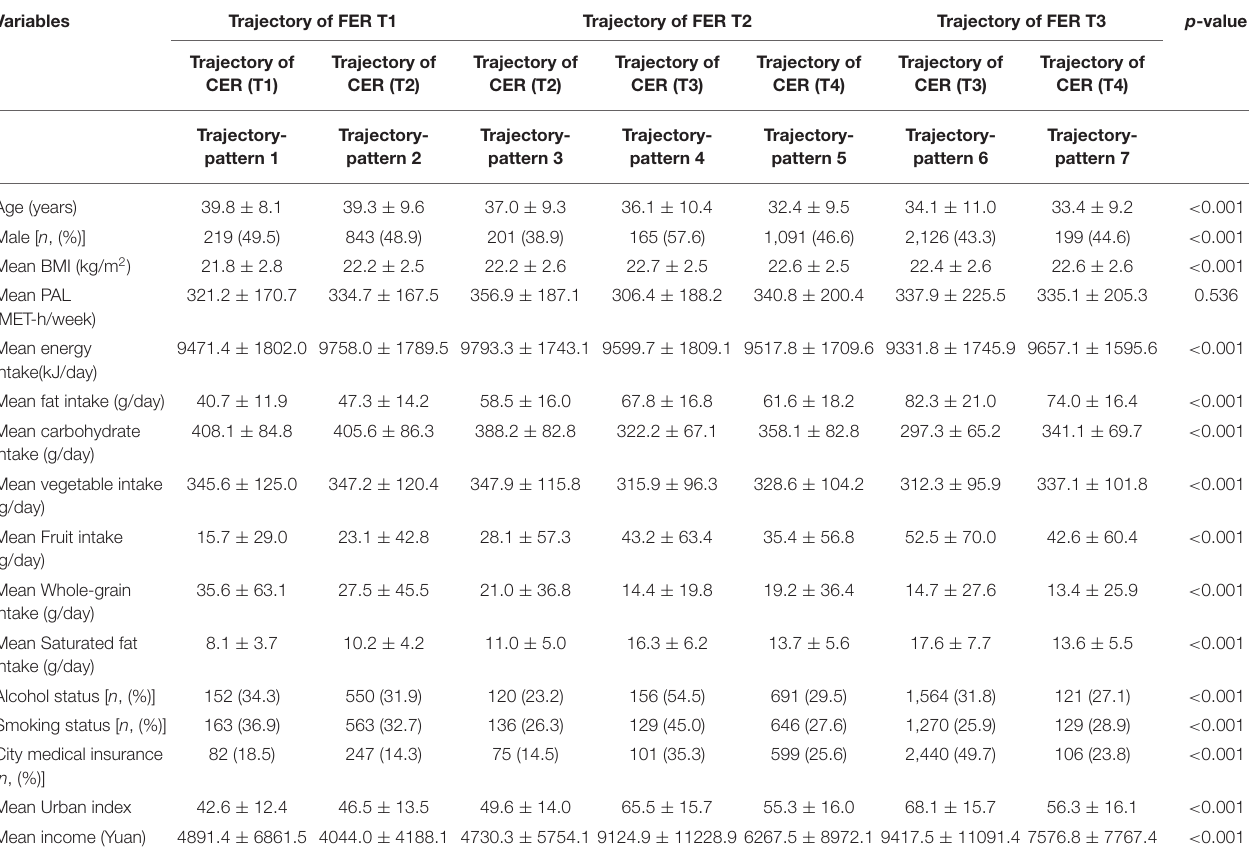
TABLE 1 | Characteristics of study variable across different trajectory-patterns a .